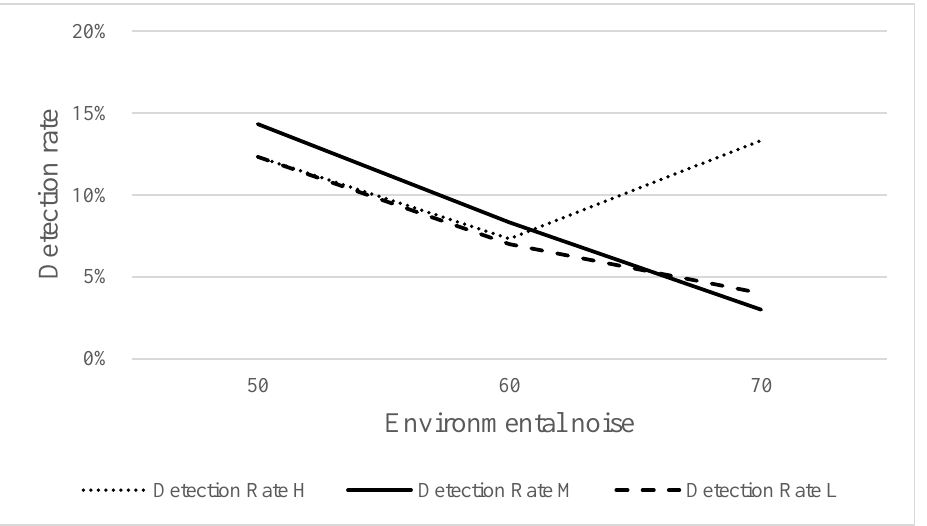
Figure 8. Detection rates for three frequencies of warning sounds under different SPLs of environ- mental noise.